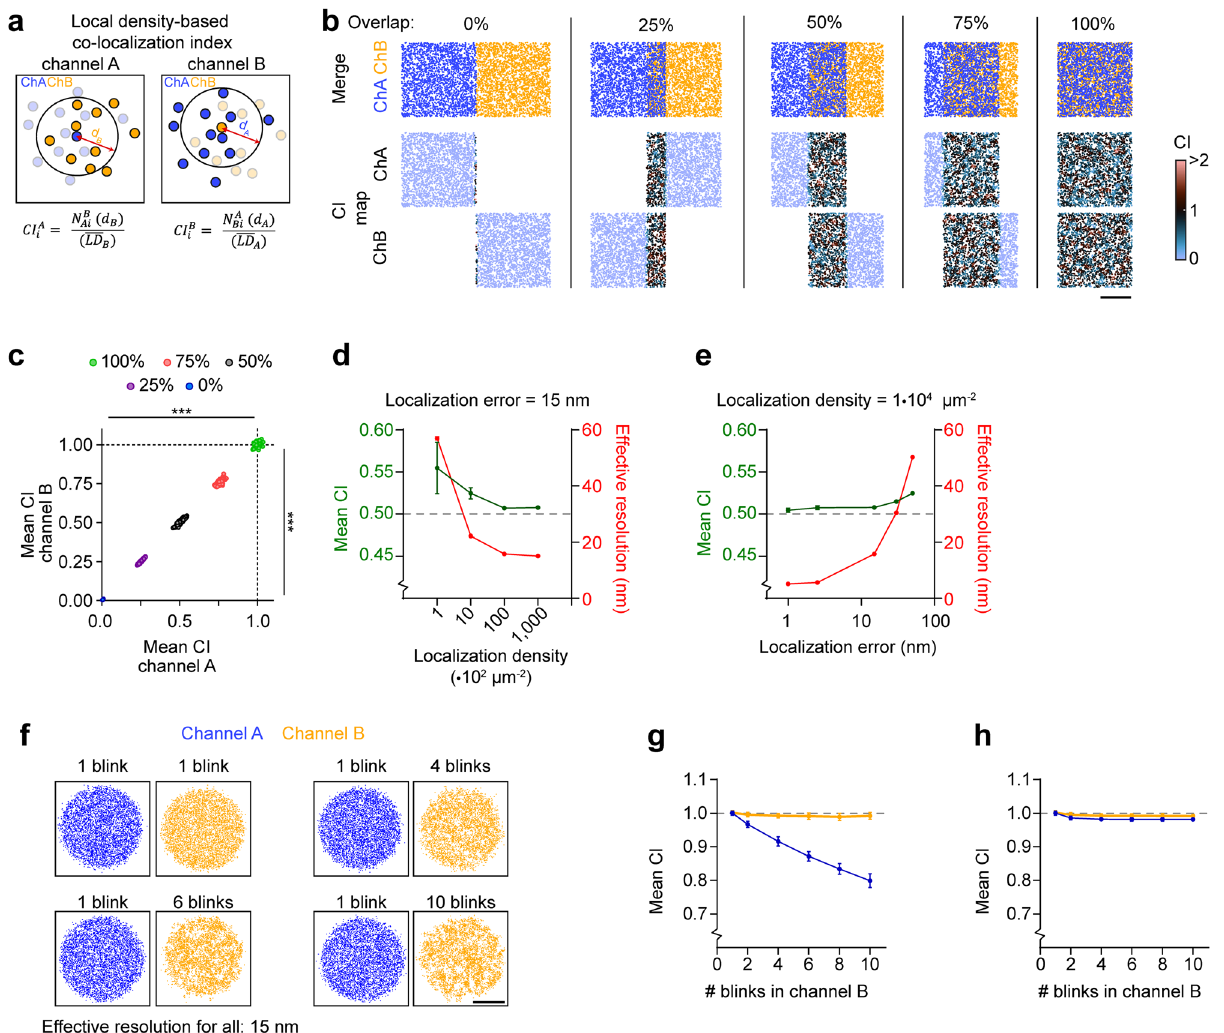
Figure 1. Local density-based co-localization index. ( a ) Concept of coordinate-based co-localization. ( b ) Simulations of point distributions with 1,000 localizations with an average localization error of 15 nm (effective resolution ~ 16 nm) and different amount of overlap between the two channels. Shown are a merge and the co-localization maps. The color code indicates the degree of co-localization. Scale bar, 100 nm. ( c ) Graph of mean co-localization index of 100 simulated point patterns for each of the conditions shown in ( b ). ( d ) Effect of changing localization density on the effective resolution and co-localization outcome (in case of 50% overlapping structures as in A). ( e ) Effect of changing localization precision on the effective resolution and co-localization outcome (in case of 50% overlapping structures as in a ). ( f ) Simulations of point distributions with increased blinking in channel B (yellow) versus channel A (blue), without changing the total number of localizations. Scale bar, 200 nm. ( g ) Analysis of co-localization for channel A (blue) and B (yellow) related to ( f ). Number of blinks in channel A remained at 1. ( h ) Analysis of co-localization with increased blinking in channel B, thereby also increasing the total number of localizations relative to channel A. Data are represented as means ± SEM. *** P < 0.001, ANOVA. CI co-localization index, LD local density, ns not scatter plot color-coded for the co-localization index. These ‘co-localization maps’ visualize the spatial distribu- tion of co-localization between the channels (Fig. 1c). Averaging the co-localization index of these localizations for 100 simulated ROIs showed that, the local density-based co-localization index scales linearly between 0 and 1 for homogenously distributed point patterns, where 0 indicates no co-localization and 1 indicates complete co-localization (co-localization index channel A, 0% overlap: 0.0067 ± 0.0002, 25% overlap: 0.25 ± 0.001, 50% overlap: 0.51 ± 0.002, 75% overlap: 0.76 ± 0.002, 100% overlap: 1.00 ± 0.001, P < 0.001, ANOVA, n = 100 point pat- terns/condition; Fig. 1c). In addition, we performed similar simulations, using sets of multiple overlapping and non-overlapping clusters (Fig. S1a–c) and challenged the method with simulations in which the localizations in channel A are surrounding, but not overlapping localizations in channel B, in a relative confined area (Fig. S2). Next, we aimed to investigate the effect of variations that usually occur in an experimental setting. First, to investigate the effect of variations in the effective resolution on the observed co-localization, we considered